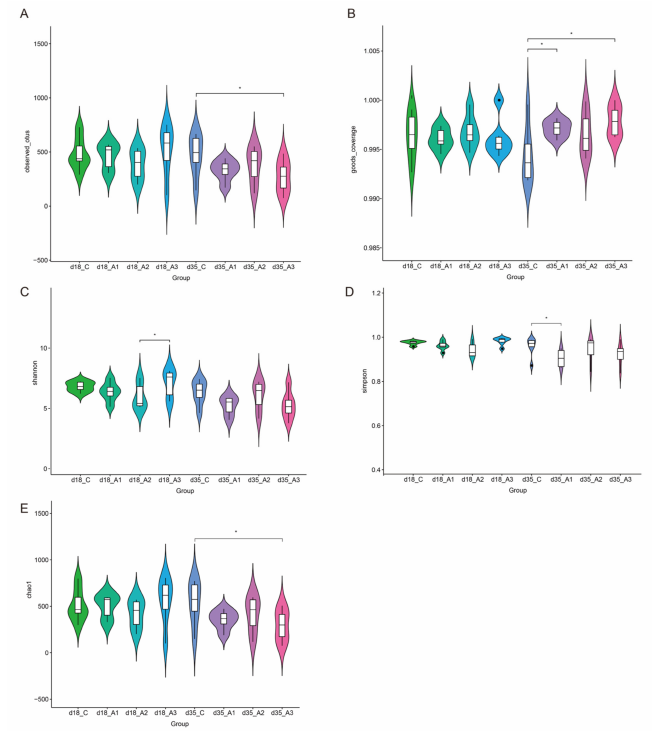
Figure 1. Comparison of the Alpha diversity index in the four groups on d 18 and d 35. Observed OTUs (observed species) ( A ). Good’s coverage ( B ). Simpson indices ( C ). Shannon indices ( D ). Chao1 indices ( E ). Labeled with * indicates a significant difference, p < 0.05; Mean values are based on six pigs (six pigs per